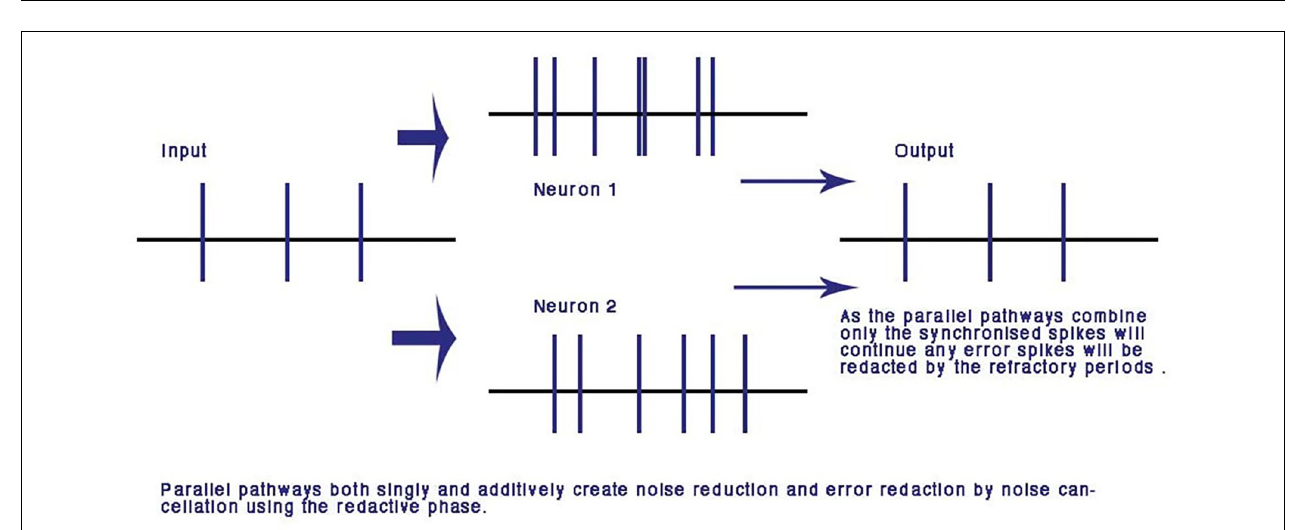
FIGURE 5 | Error and noise redaction by phase ternary computation. In parallel connections, any out of phase errors and spontaneous spikes are automatically redacted by the refractory periods of neighboring spikes: using the CAP any phase shift or spontaneous spike will be reduced to the resting potential by the colliding neighbor CAP. From Johnson and Winlow (2017a) – reproduced under the Creative Commons